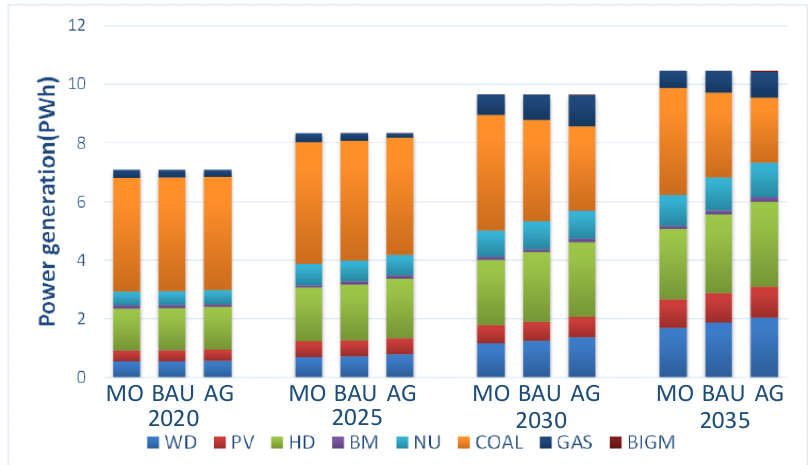
Figure 4. Comparison of the national electricity generation structure over the planning horizon under the MO, BAU and AG electricity marketization scenarios. Table 12. Comparison of the RES share of the total electricity generation over the planning horizon under the MO, BAU, AG electricity marketization scenarios.